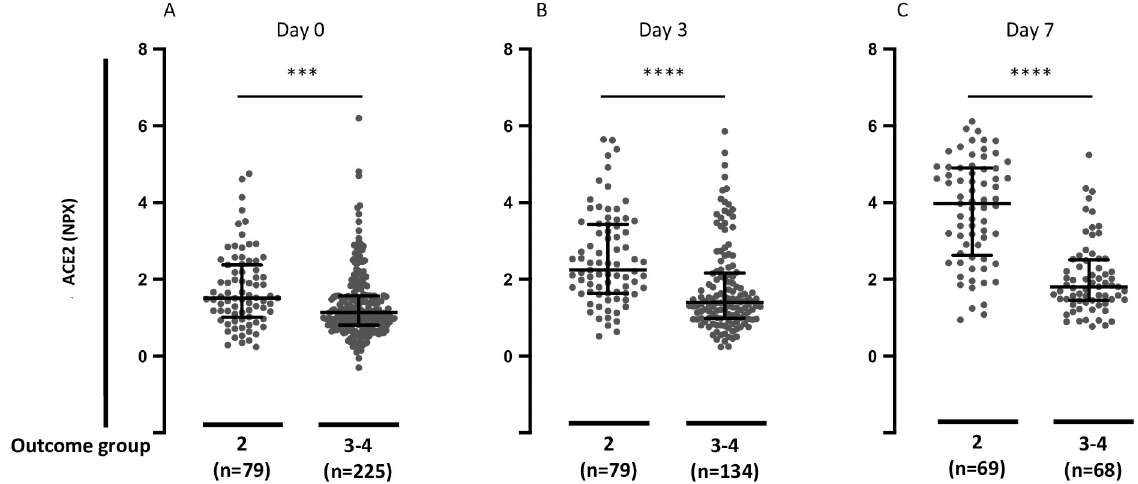
Fig 3. Plasma ACE2 in hospitalized COVID-19 positive patients segregated by acuity groups A2 (intubated) versus A3-A4 (not intubated). A. Day 0 plasma ACE2 in hospitalized COVID-19 positive patients by acuity groups A2 (intubated) or A3-A4 (not intubated) for day 0 study window (enrollment plus 24 hours). B. Day 3 plasma ACE2 in hospitalized COVID-19 positive patients by acuity groups A2 versus A3-A4 for day 3 study window. C. Day 7 plasma ACE2 in hospitalized COVID-19 positive patients by acuity groups A2 or A3-A4 for day 7 study window. Acuity categories: A2 = Intubated, ventilated. A3 = Hospitalized, supplementary O2 required. A4 = Hospitalized, no supplementary O2 required. Bars indicate median and interquartile range. Data were analyzed using the Mann Whitney test. ��� P < 0.001. ���� P <